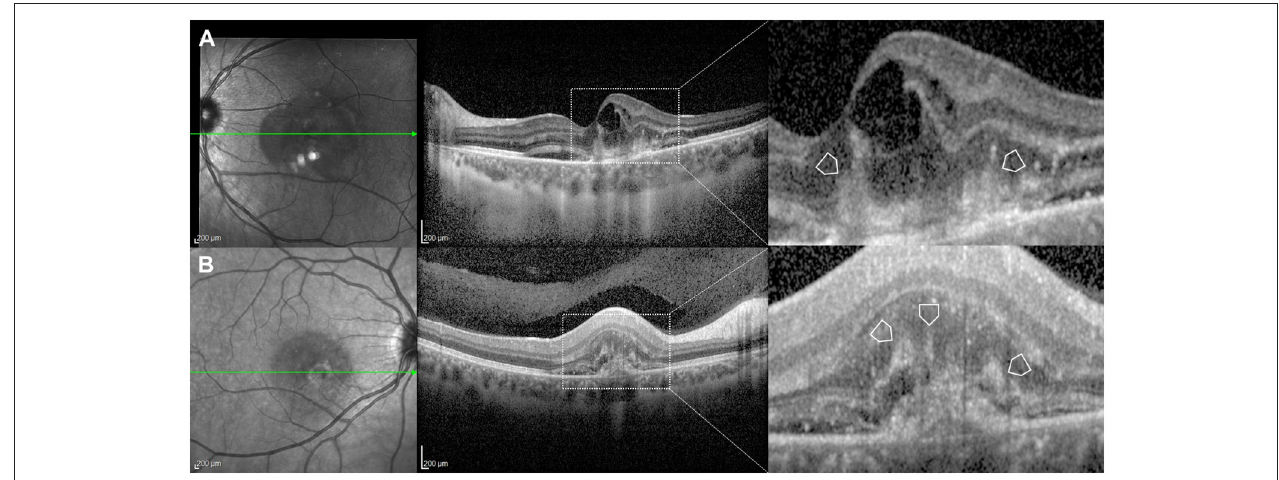
FIGURE 7 | Illustrative examples of inflammatory choroidal neovascularization (CNV) in cases of a 37-year-old female (A) and a 25-year-old female (B) with multifocal choroiditis. The enlarged sections of the scans sign show typical multiple finger-like projections (arrowheads) arising from the area of CNV into the outer retinal layers. These represent the pitchfork sign as described by Hoang et al. ( 28).